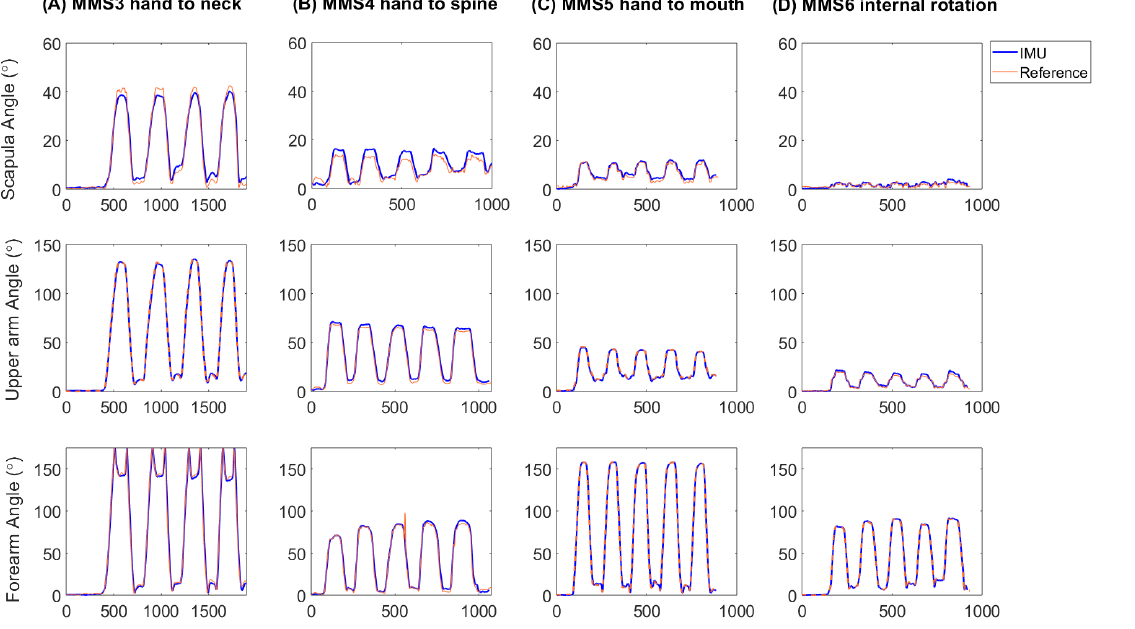
Figure 2. Examples of data from one test person during four of the tasks included in the modified Mallet score MMS3 hand to neck ( A ), MMS4 hand to spine ( B ), MMS5 hand to mouth ( C ), MMS6 internal rotation ( D ) as simultaneously measured with the reference system (red line) and the IMU system (thick blue line). The segment helical angle was calculated for scapula (upper row), upper arm (middle row) and forearm (bottom row).